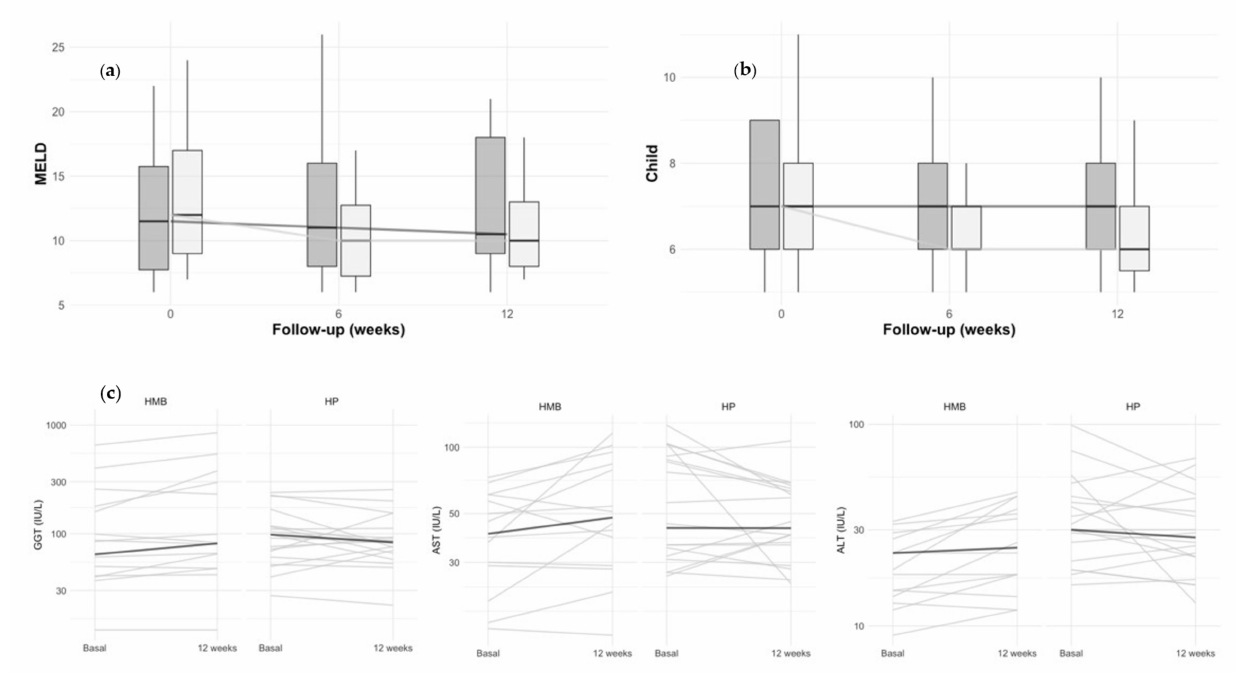
Figure 2. Longitudinal changes in MELD, Child-Pugh scale and in liver transaminases. Longitudinal changes in the MELD ( a ) and Child-Pugh ( b ) scales according to HMB (white) and HP (gray) treatments. ( c ) Changes in liver transaminases. Each line represents the variation of an individual patient during the trial, thick lines represent the medians of each